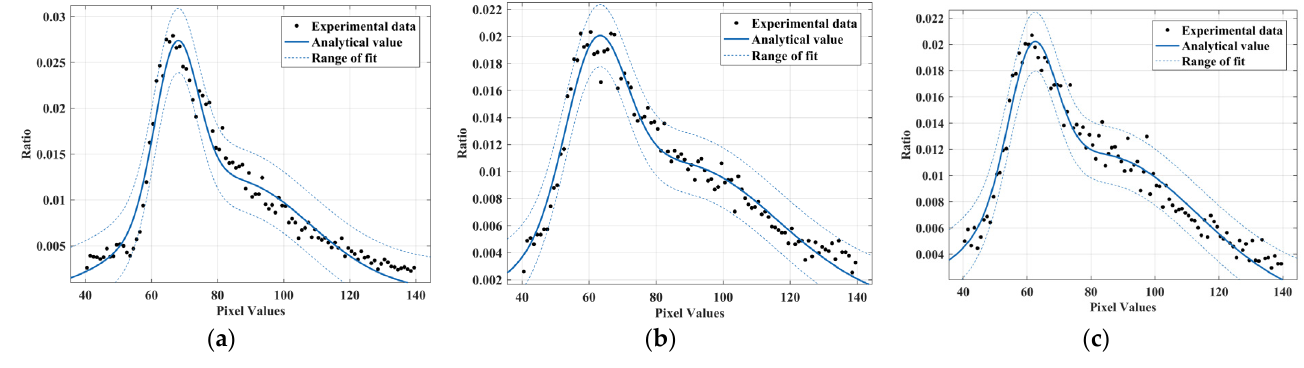
Figure 5. Fitting of a two-component one-dimensional mixture Gaussian curve to noise amplitude under high accumulated doses: ( a ) 300 Gy; ( b ) 500 Gy; and ( c ) 1000 Gy. Table 2. Two-component one-dimensional Gaussian mixture fitting noise amplitude distribution parameters.